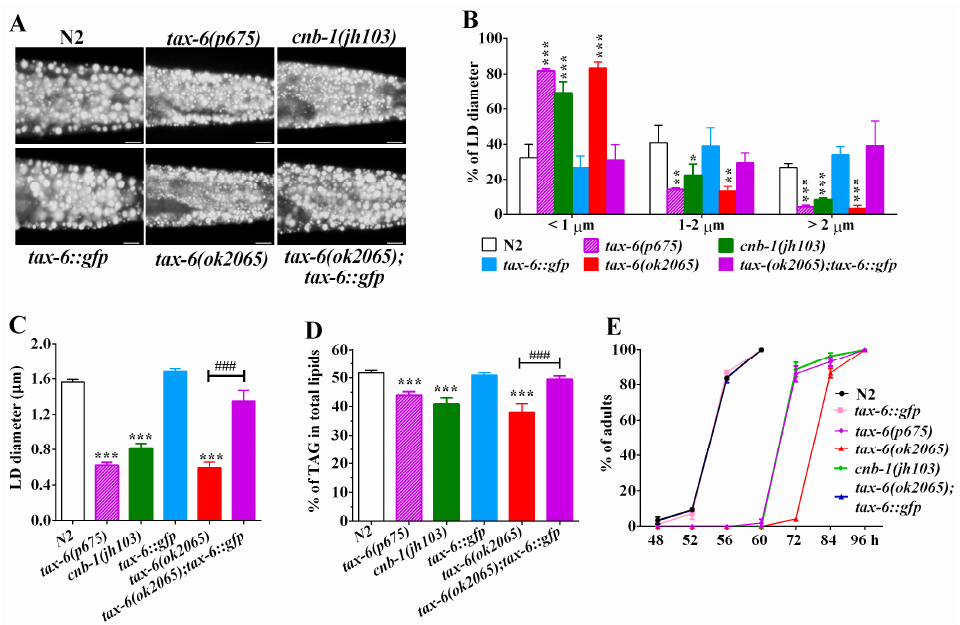
Figure 1. Loss-of-function of calcineurin genes tax-6 or cnb-1 exhibited a remarkable reduction in fat accumulation. ( A ) Nile Red staining of fixed worms. Representative animals with stained lipid droplets (LDs) in the posterior region. In all of the represented animals, the anterior is indicated on the left and the posterior is indicated on the right. Scale bar represents 10 μ m; ( B ) Distribution of the lipid droplets (% lipid droplets) were measured from Nile Red staining of fixed worms from ( A ), n = 10 for each worm strain; ( C ) The average size of the lipid droplets (LD) were measured from Nile Red staining of fixed worms from ( A ), n = 10 for each worm strain; ( D ) percentage of triacylglycerol (TAG) in total lipids (TAG + phospholipids). Data are presented as the means ± SD of at least three biological repeats; and ( E ) The growth rate of N2, tax-6(ok2065) , cnb-1(jh103) and tax-6(p675) worms. n > 150 worms. Data are presented as the means ± SD. * indicates significant difference between wild-type N2 and a specific worm strain, * p < 0.05, ** p < 0.01, *** p < 0.001. # indicates significant difference between two indicated worm strains, ### p < 0.001.